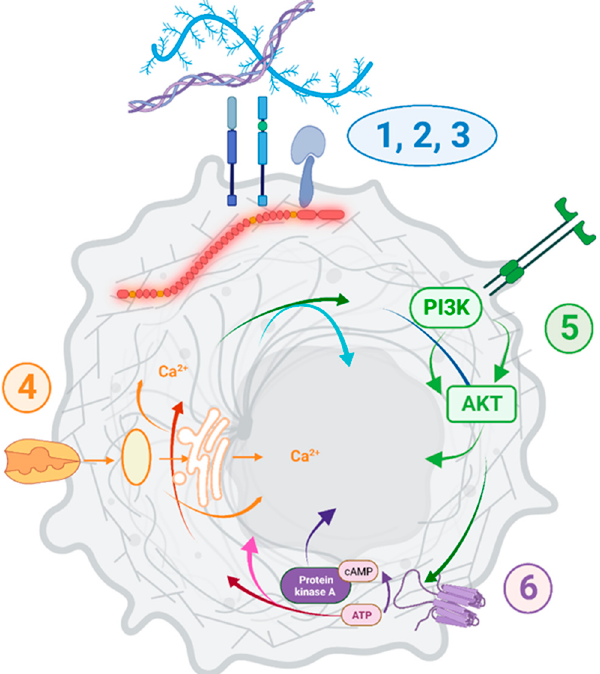
Figure 9. A schematic representation of the key pathways enriched in the DEGs in primary tumors with low DMD gene expression that are shared with DMD skeletal muscle. Top six pathways that were identified in more than 50% of primary tumor samples with low DMD expression are displayed schematically, including ( 1 ) ECM-receptor interaction, ( 2 ) Cell adhesion molecules, ( 3 ) Focal Adhesion, ( 4 ) Calcium Signaling, ( 5 ) PI3K-Akt signaling, ( 6 ) cAMP signaling. Arrows suggest the potential additional interactions between pathways. Dp427 only is shown.